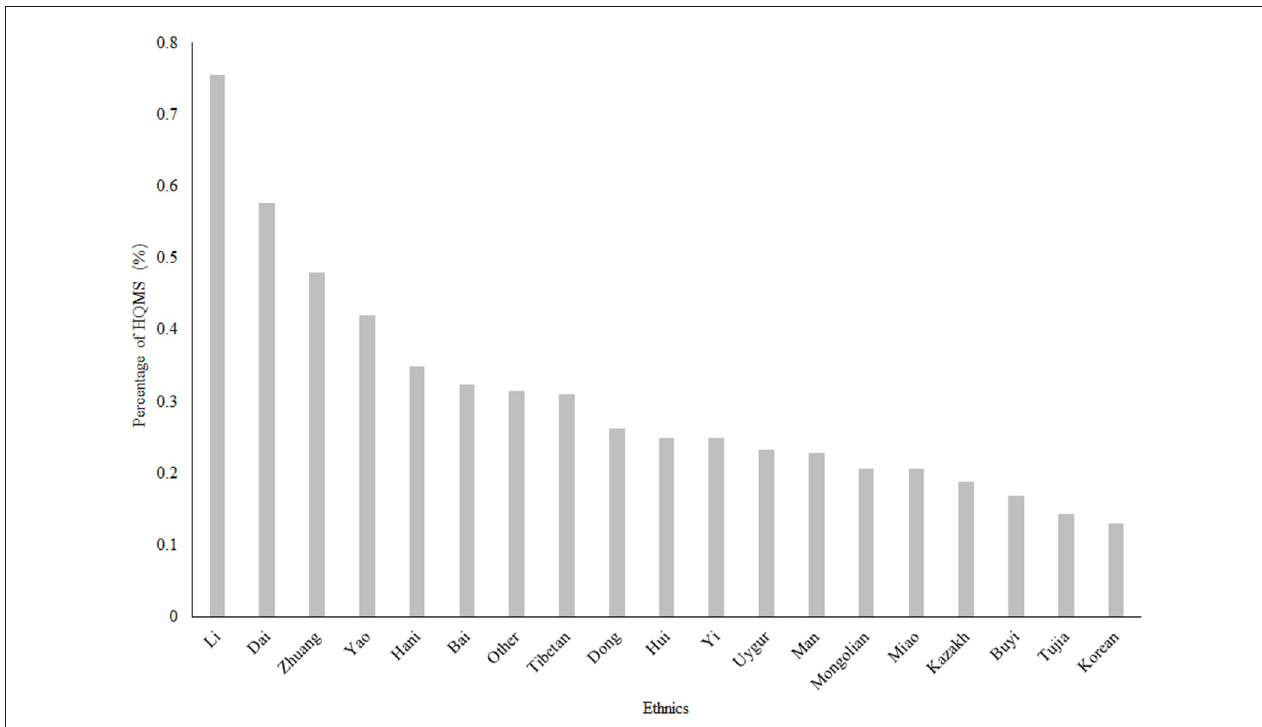
FIGURE 2 | The ethnic distribution of SLE in China in 2017. The Li, Dai and Zhuang minorities had the higher frequencies of SLE, with frequencies of 0.755, 0.576, and 0.48%, respectively. HQMS, Hospital Quality Monitoring System Note: Information on races was missing for 11,648 (4.62%) of all 5-year SLE patients included. heart involvement was the least common from 2013 to 2017 ( Supplementary Figure 4